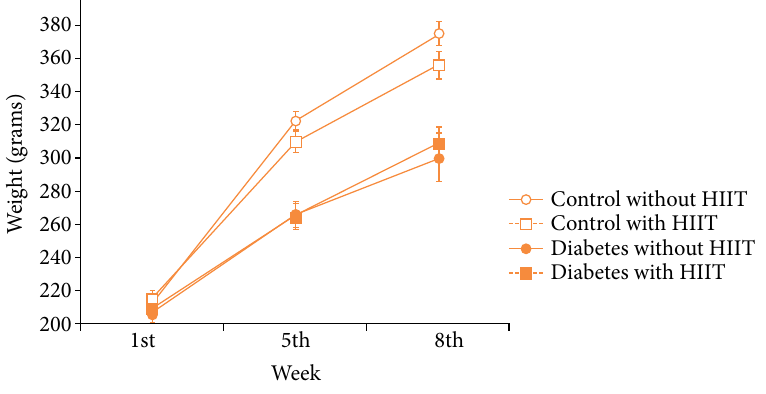
Figure 4 - The weight of the animals in each treatment, in the different weeks evaluated in the study. Each symbol represents the mean, and the bar stands for the standard error of the